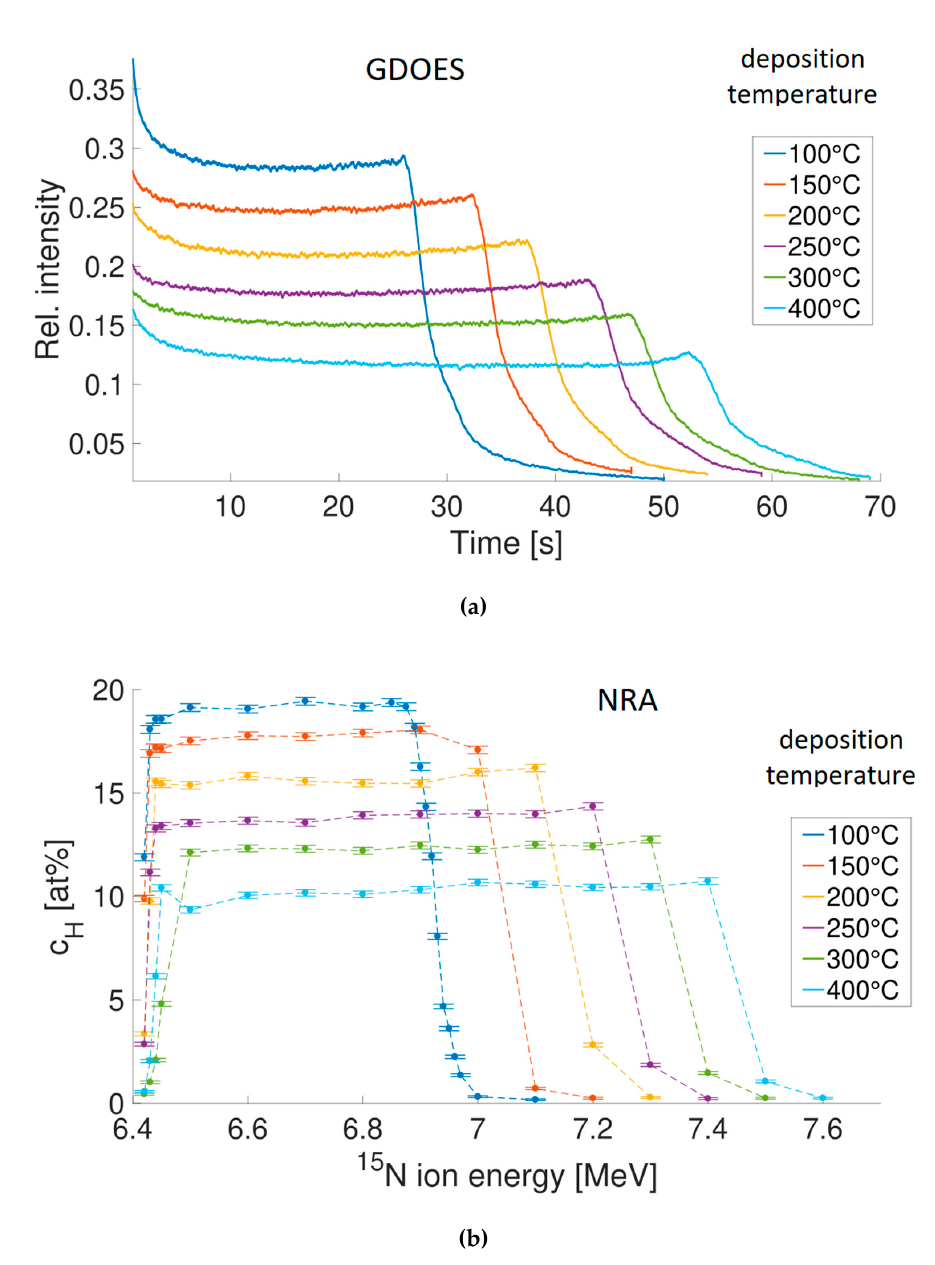
Figure 4. Hydrogen depth profiles of a-Si:H samples determined by GDOES ( a ) and NRA ( b ), see also Section 3.2.2. The higher was the deposition temperature, the lower is hydrogen concentration in the coating and the greater is its thickness [37]. Ordinate scale in GDOES: raw data, intensities of the H I line at 121.567 nm relative to the intensity of the Ar II line at 415.29 nm. Ordinate scale in NRA: absolute hydrogen concentration. Reproduced from Ref. [37] with a courtesy of Dr. Jonathan Steffens (University of Konstanz).